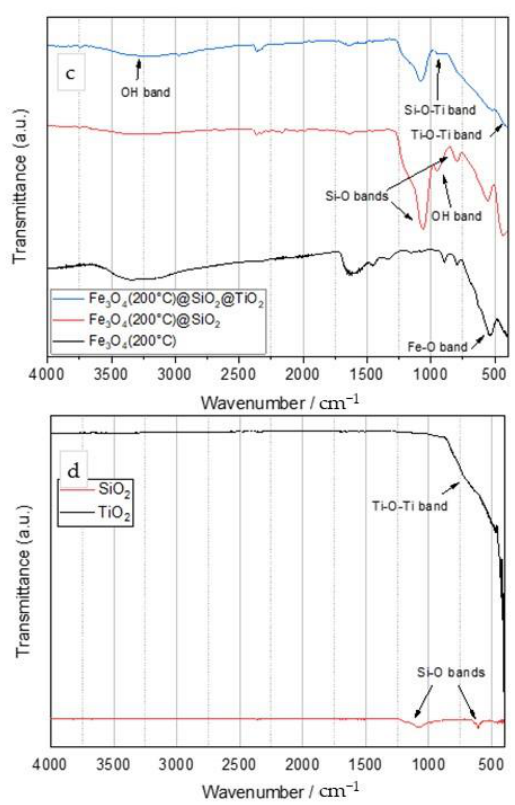
Figure 1. FTIR spectra of Fe 3 O 4 (black line), Fe 3 O 4 /SiO 2 (red line), and Fe 3 O 4 /SiO 2 /TiO 2 (blue line) particles synthesized by the microwave-assisted method at 100 ◦ C ( a ), 150 ◦ C ( b ), and 200 ◦ C ( c ). ( d ) FTIR spectra of pure TiO 2 and SiO 2 .